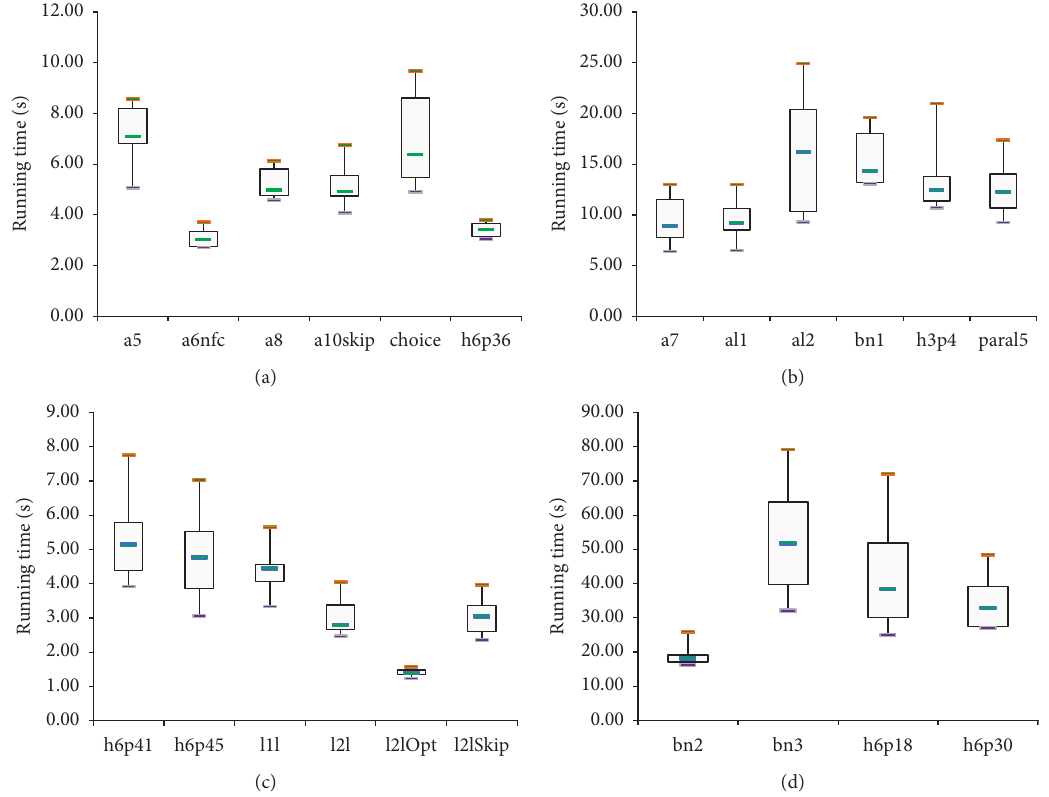
Figure 4: Running time of DEMiner on 22 event